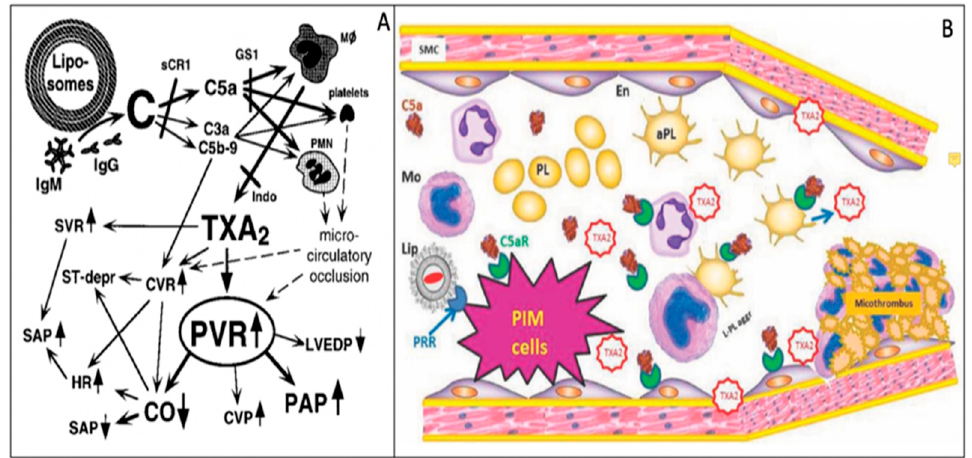
Figure 2. Complex mechanism of liposome-induced CARPA in pigs; schematic ( A ) and visual ( B ) illustration of causally related events, reproduced from Refs. [15] and [66], respectively. ( A ) The arrows indicate causal relationships among the physiological changes; solid and dashed lines indicate experimentally established and hypothetical changes. ( B ) Imaginary snapshot of a pulmonary capillary during CARPA in pigs; the PIM’s TXA2 response to C5a and liposome binding is combined with microthrombus formation on the capillary wall, amplifying the vasoconstrictive effect of TXA2. Abbreviations: ( A ) C, complement; HR, heart rate; Mf, macrophage; Indo, indomethacin; CVR, coronary vascular resistance; ST-depr, ST-segment depression on the ECG; sCR1, soluble C receptor type 1, a C inhibitor; GS1, anti-porcine C5a antibody, PVR, pulmonary vascular resistance, CVR, central vascular resistance, CO, cardiac output, SVR, systemic vascular resistance, HR, heart rate, SAP, systemic arterial pressure, PAP, pulmonary arterial pressure; ( B ) Lip, liposome, aPL, activated platelet; Mo, monocyte; L-P aggr, leukocyte-platelet aggregate; PRR, pattern recognition receptors; En, endothelial cells; SMC, smooth muscle cells.